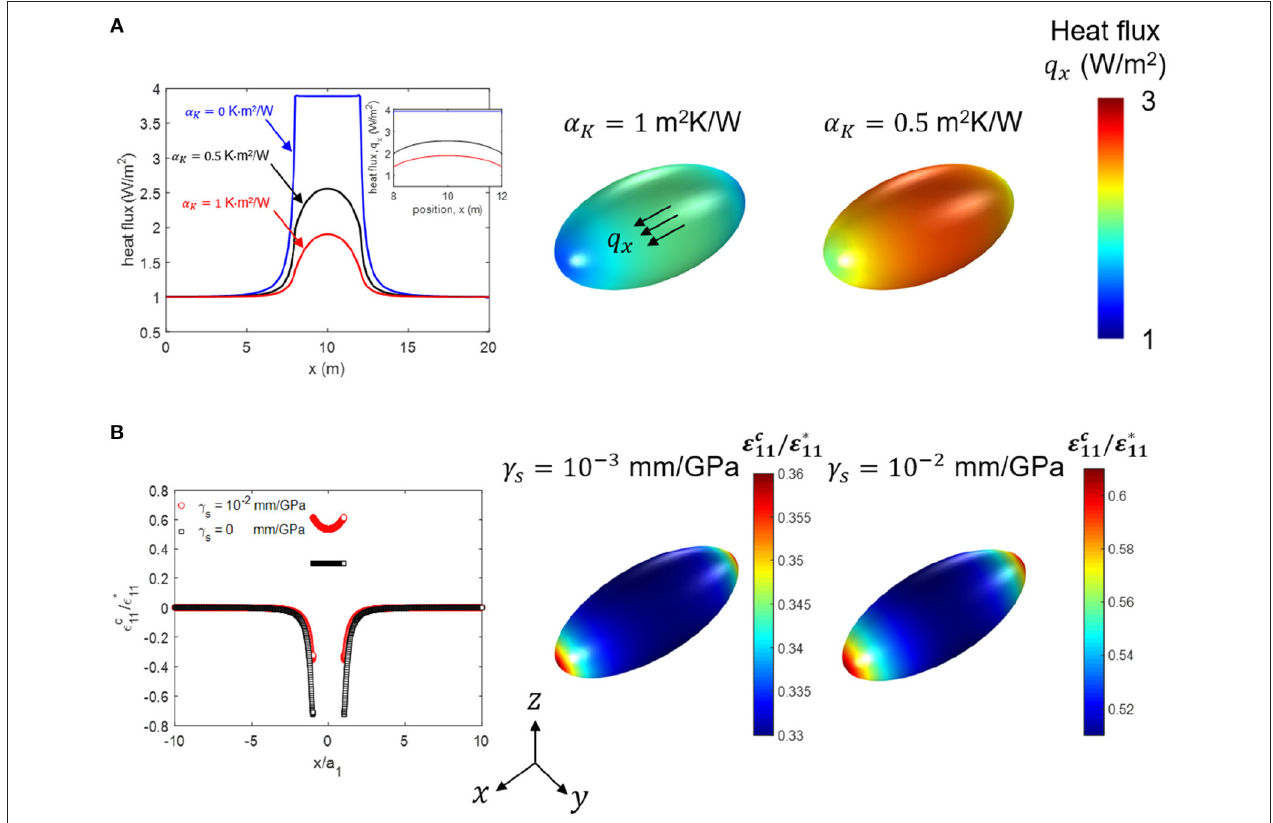
a x / a y a x / a z 2 . The material properties used for = = 200GPa, ν 0 0.25 (Lee et al., (cid:0) (cid:1) = =